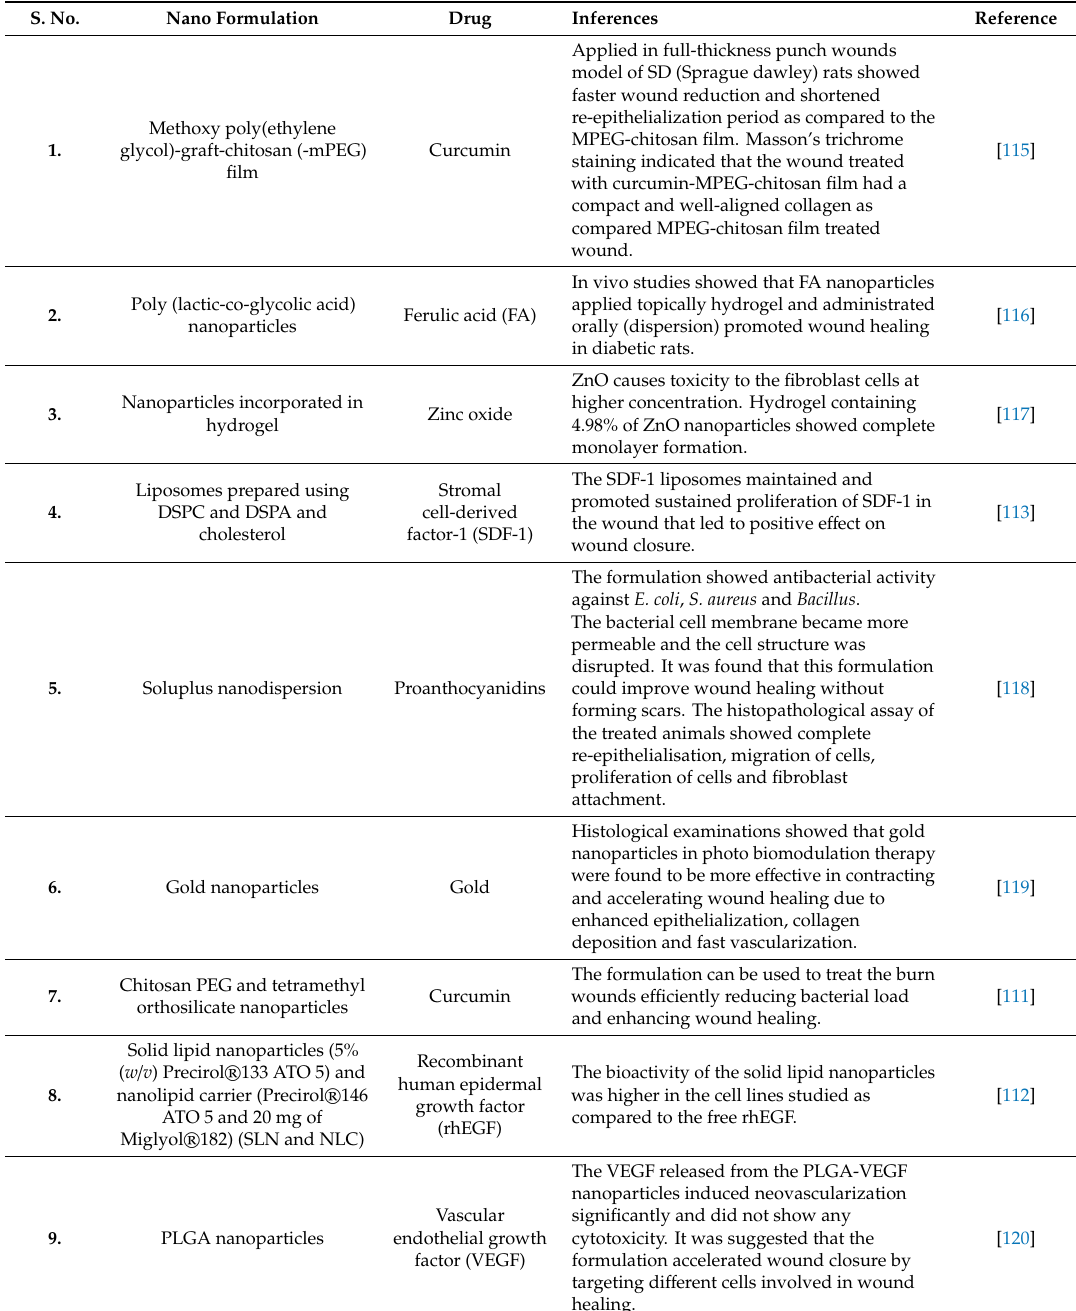
Table 4. Reported nanoformulations for wound